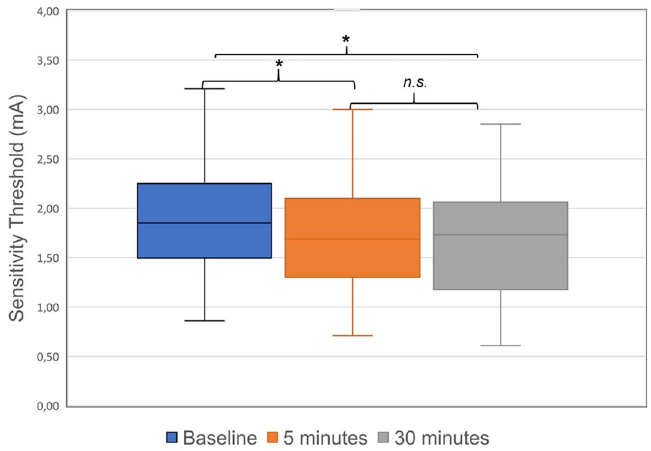
Figure 1. Measurements of sensitivity threshold presented as mean and standard deviation. The values 5 min after baseline (1.74 ± 0.56 mA, p = 0.027, Bonferroni corrected p = 0.081) and 30 min after baseline (1.67 ± 0.58 mA; p = 0.011, Bonferroni corrected p = 0.033) are significantly lower compared to baseline, but there is no difference between 5 and 30 min after baseline ( p = 0.321, Bonferroni corrected p =